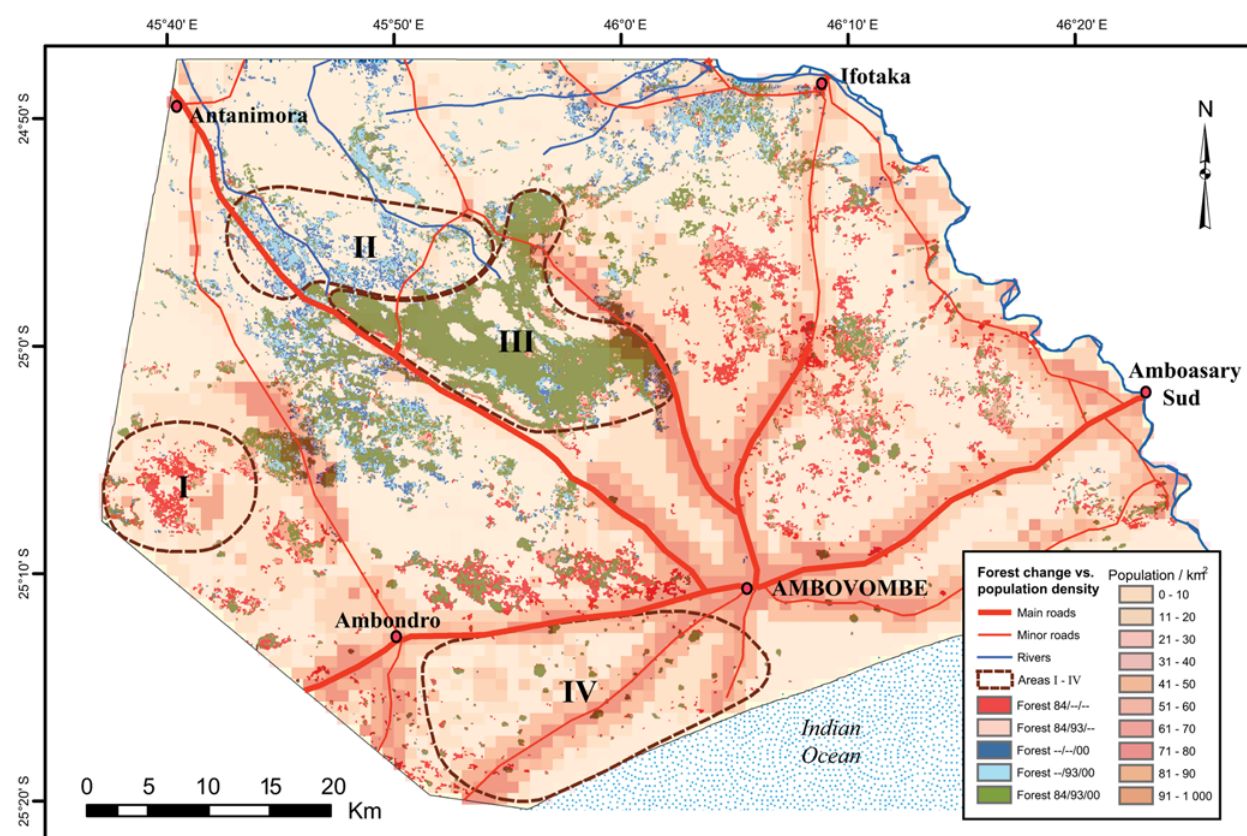
Figure 7. The four surveyed areas and estimates of human population density and distances to main roads as indicator of access to markets of forest products. Population censuses based on LandScan 2001 Global Population Database (Oakridge, TN: Oak Ridge National Laboratory http:// www.ornl.gov/gist/). Map source: Foiben-Taosarintanin’i Madagasikara (FTM) doi:10.1371/journal.pone.0000402.g007 PLoS ONE |